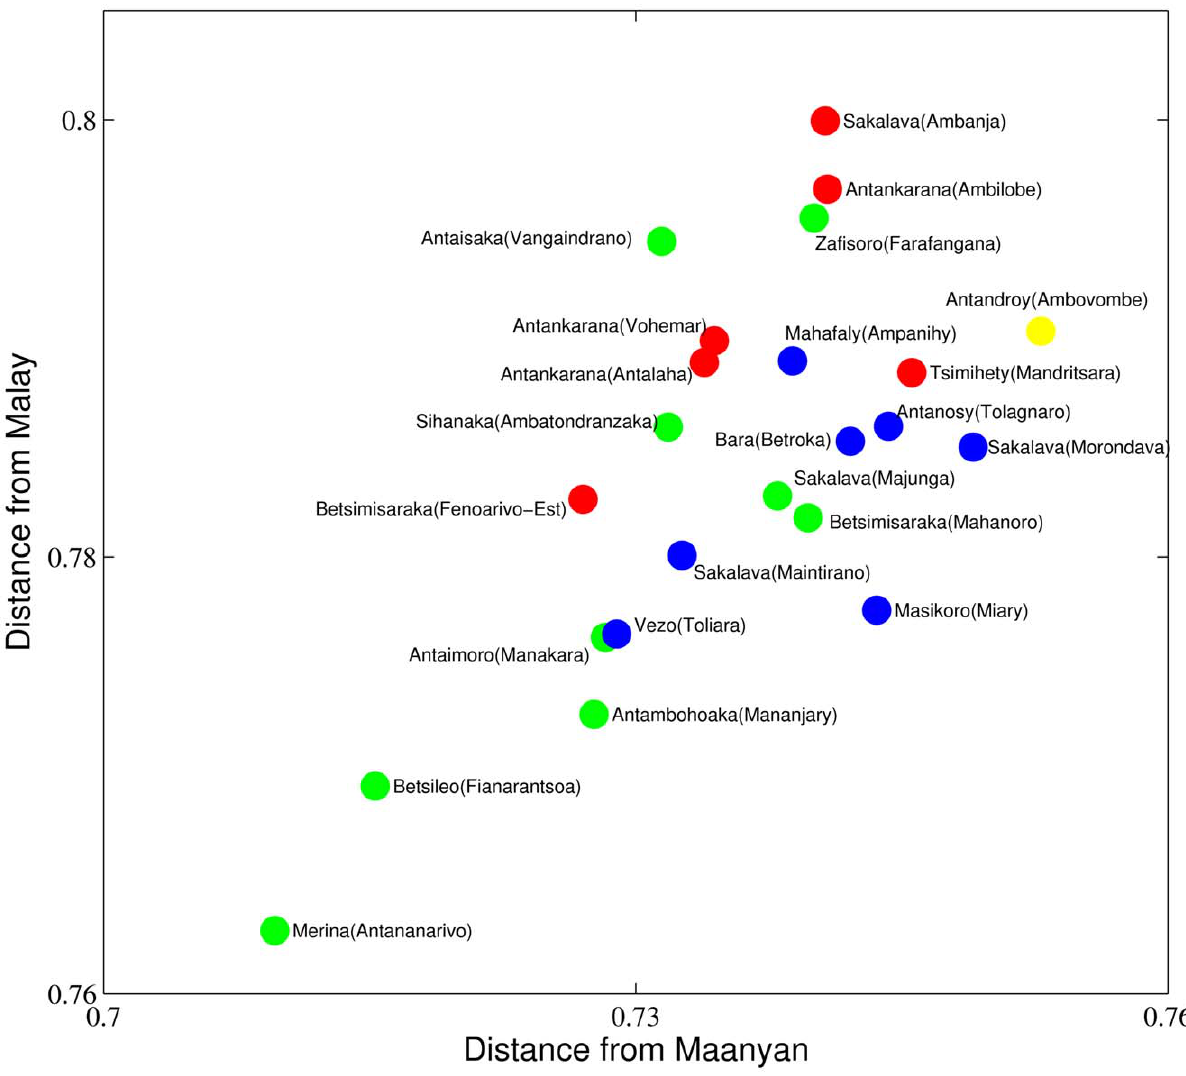
Figure 4. Lexical distances of Malagasy dialects from Malay and Maanyan. The 23 dialects are indicated with the same colors as in Fig. 2. Highlands dialects together with south-east coast Mananjary and Manakara dialects show the smallest distance from both of the two Indonesian languages.